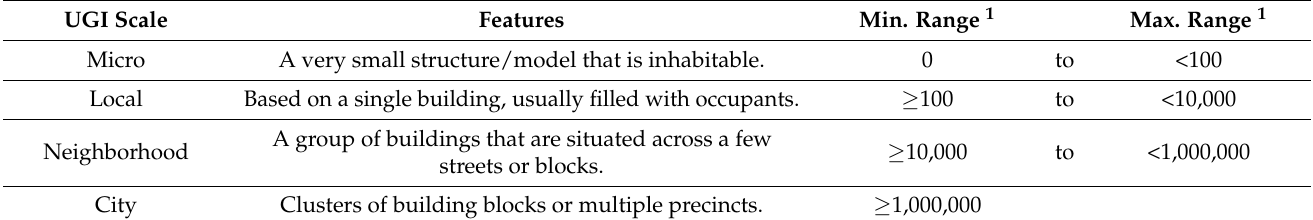
Table 2. The scale of the UGI compared with the size of the studied site.